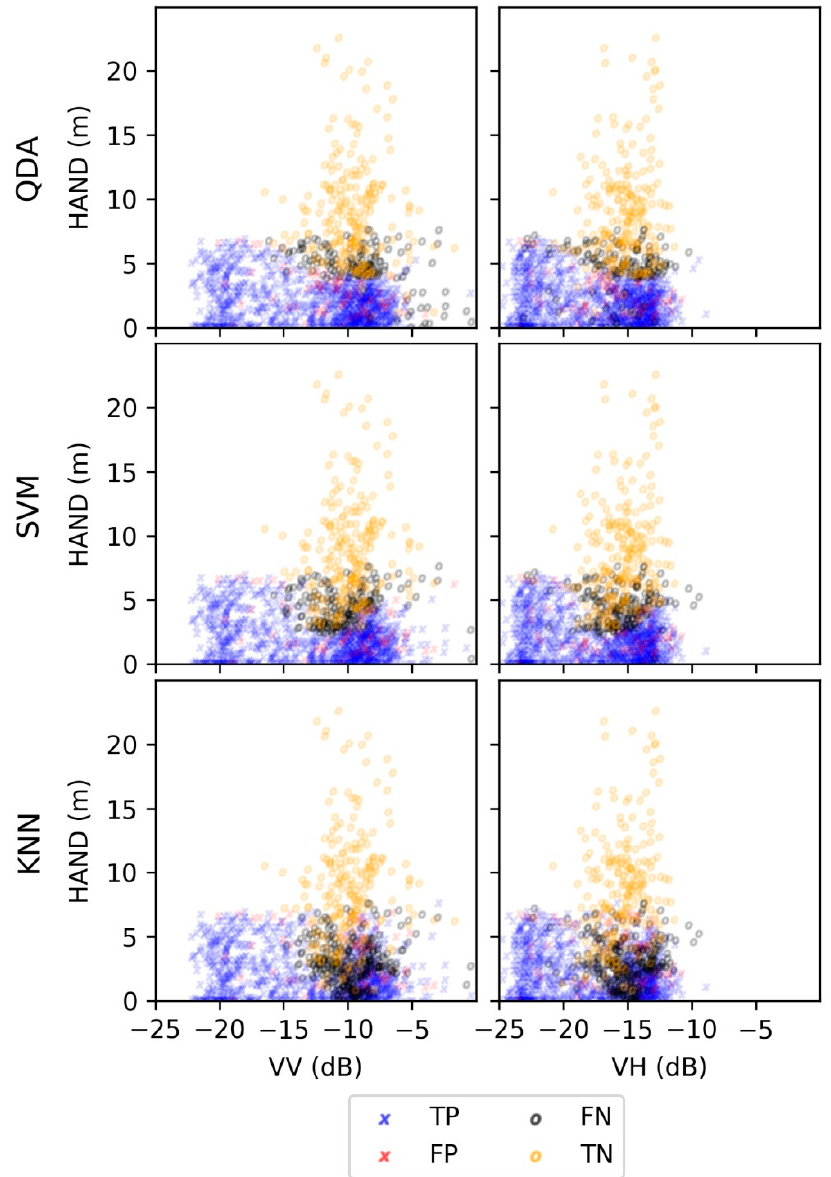
Figure 10. Primary metrics for all three classifiers on Goldsboro illustrated as scatter points for HAND vs. VV and HAND vs. VH for the feature set that included HAND. Demonstrates the decision boundaries generated by the classifiers and the relationship between SAR backscatter and HAND. Points are a random sample of overall study area ( ≤ 0.2%).